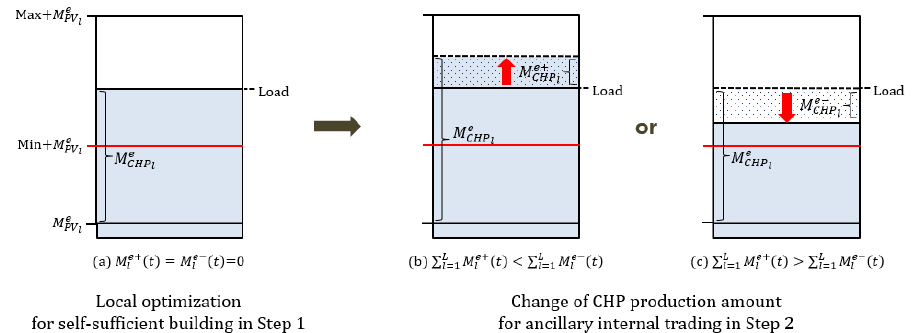
Figure 6. Self-sufficient